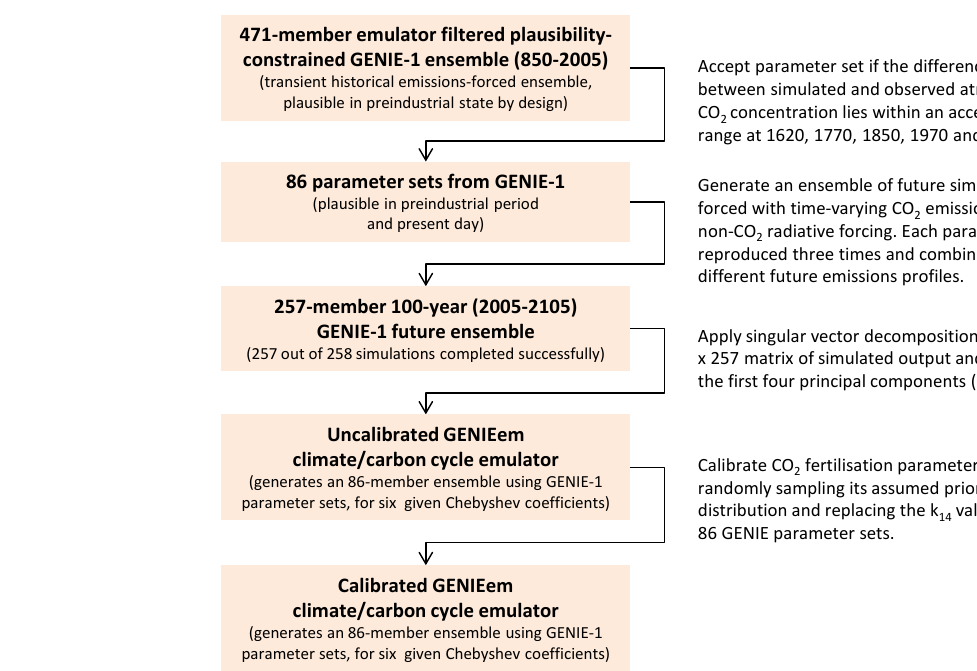
Figure 1. Schematic describing the construction of